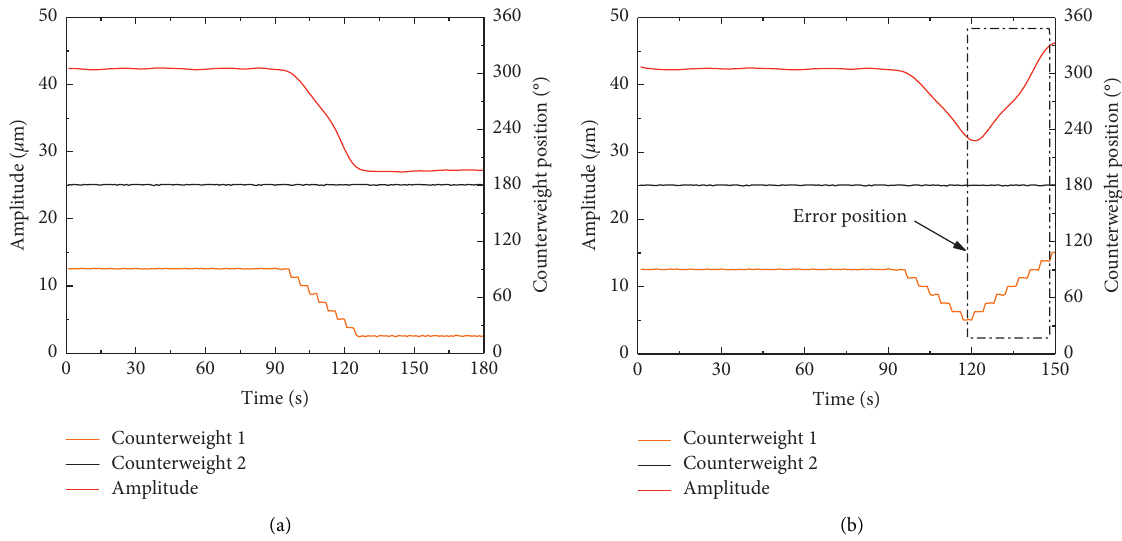
Figure 2: Schematic diagram of the vibration suppression effect of the balance head.